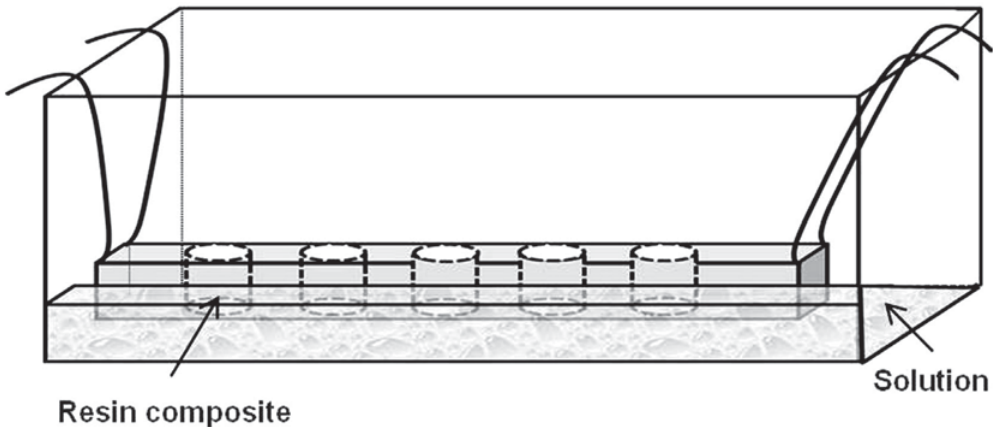
Figure 1- Schematic representation of the ethylene vinyl acetate (EVA) sheet rack used for the color change